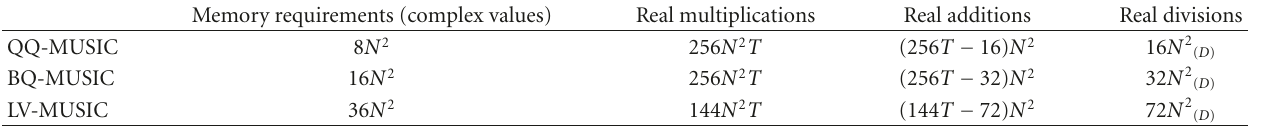
Table 2: Computational e ff ort for covariance